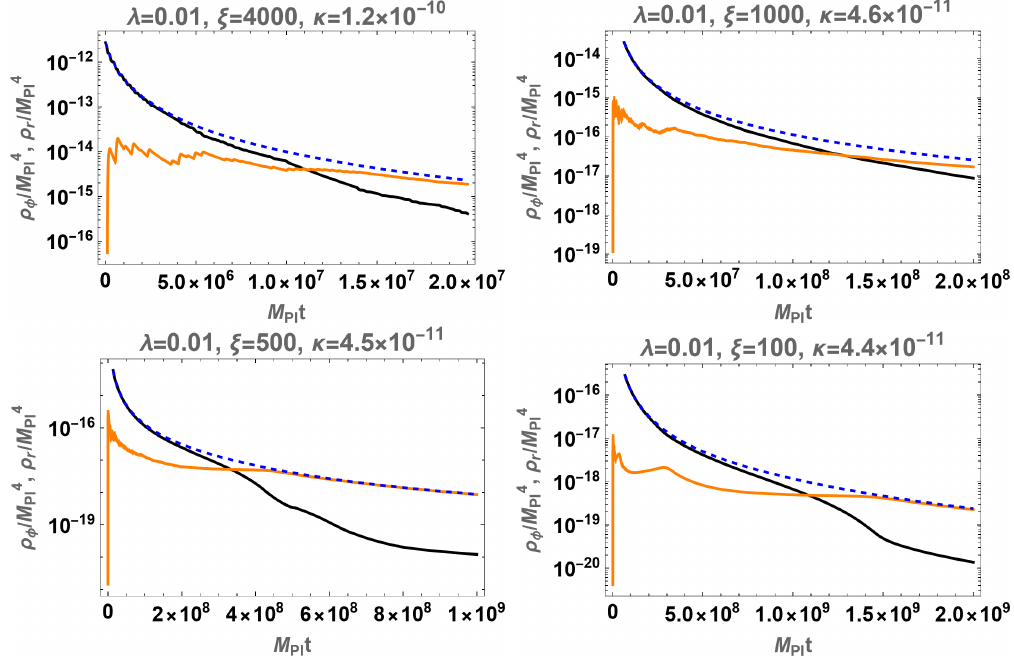
Figure 3 . Time evolution of the energy densities during reheating. Inflaton energy density, ρ φ ≡ ρ σ + h , the radiation energy density, ρ r , and the total energy density, ρ σ + h + ρ r , are shown in black, orange and blue dashed lines, respectively. We chose ξ = 4000 , 1000 , 500 , 100 , for top left, top right, down left, and down right plots,